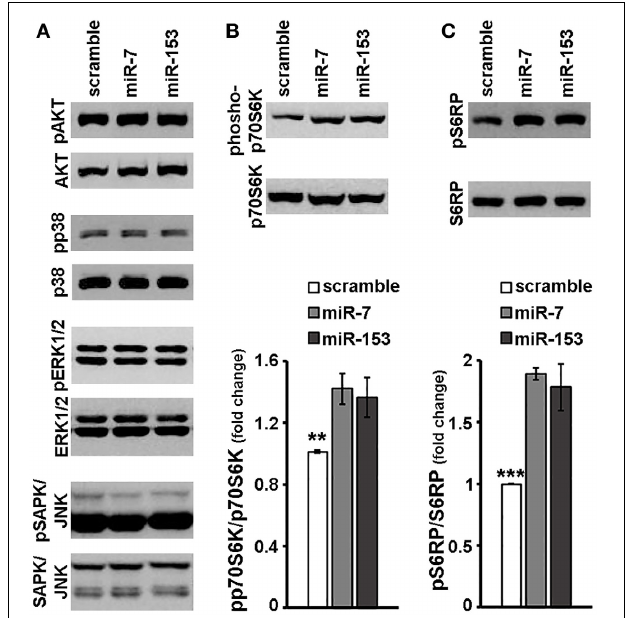
FIGURE 4 | miR-7 and miR-153 activated p70S6K signaling cascade in cortical neurons. Six to seven days old primary cortical neurons were transduced with adenoviral particles expressing scramble miR, miR-7, or miR-153 and were lysed 48h post-transduction. (A) Equal amounts of total protein from lysates of cortical neurons were analyzed on 10% SDS-PAGE and immunoblotted with antibodies specific for phosphorylated forms of AKT, p38 MAPK, ERK1/2 SAPK/JNK. To ensure equal loading membranes were re-probed against AKT, p38 MAPK, ERK1/2, and SAPK/JNK, respectively. (B,C) Equal amounts of total protein from lysates of cortical neurons were analyzed on 10% SDS-PAGE and immunoblotted with antibodies specific for phosphorylated forms of p70S6K (B) as well as for the phosphorylated forms of p70S6K substrate, S6RP (C) . To ensure equal loading, membranes were re-probed against p70S6K and S6RP, respectively. Quantification of the results was performed by scanning densitometry. Bars in the graph depict mean ± s.e.m. Note that compared to scramble-transduced controls, primary cortical neurons transduced with miR-7 or miR-153 expressing adenoviruses displayed a significant increase only in the levels of phosphorylated forms of p70S6K and S6RP. ∗∗ P ≤ 0 . 01, ∗∗∗ P ≤ 0 .